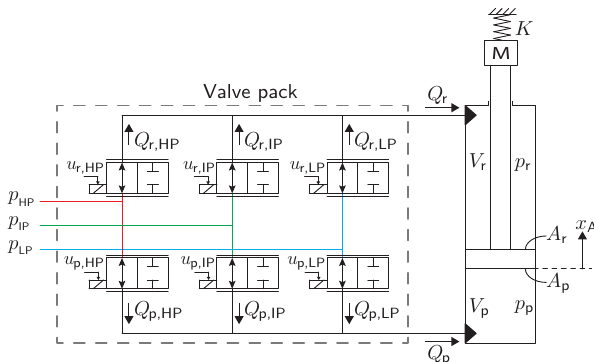
Figure 5: Illustration of a cylinder and the associated valve pack with defined variables used for modeling.